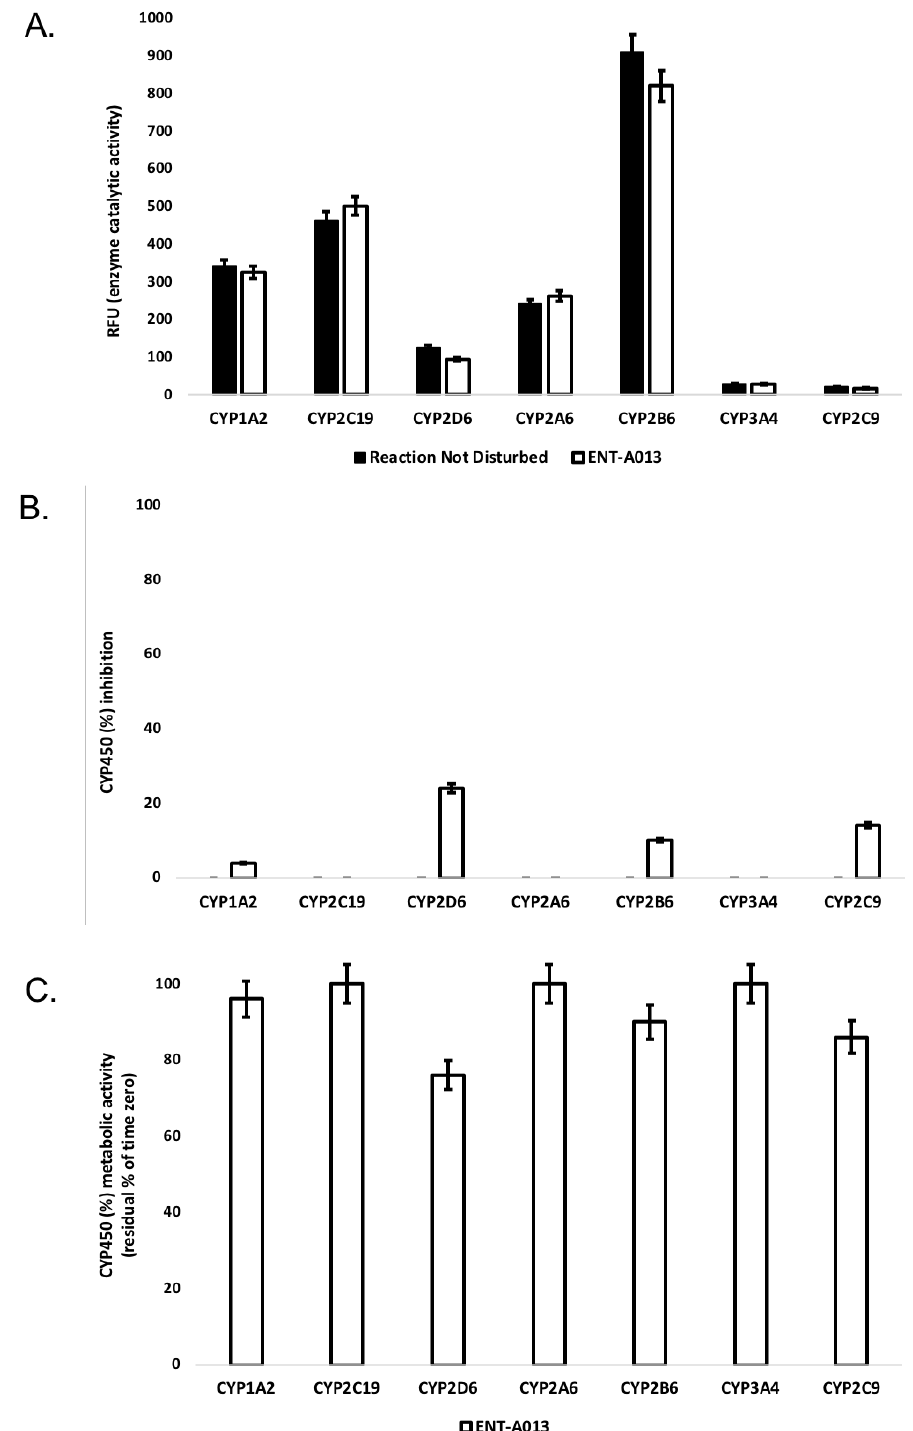
Figure 2. ( A ) Enzyme (catalytic) activity of the CYP1A2, CYP2A6, CYP2B6, CYP2C9, CYP2C19, CYP2D6 and CYP3A4 isoenzymes upon the administration of ENT-A013 at 1 µ M (60 min). RFU: relative fluorescence units. Reaction Not Disturbed: reaction without ENT-A013. ( B ) CYP450 (%) inhibition of CYP1A2, CYP2A6, CYP2B6, CYP2C9, CYP2C19, CYP2D6 and CYP3A4 isoenzymes upon the administration of ENT-A013 at 1 µ M (60 min). ( C ) CYP450 (%) metabolic activity of CYP1A2, CYP2A6, CYP2B6, CYP2C9, CYP2C19, CYP2D6 and CYP3A4 isoenzymes upon the administration of ENT- A013 at 1 μM (60 min).